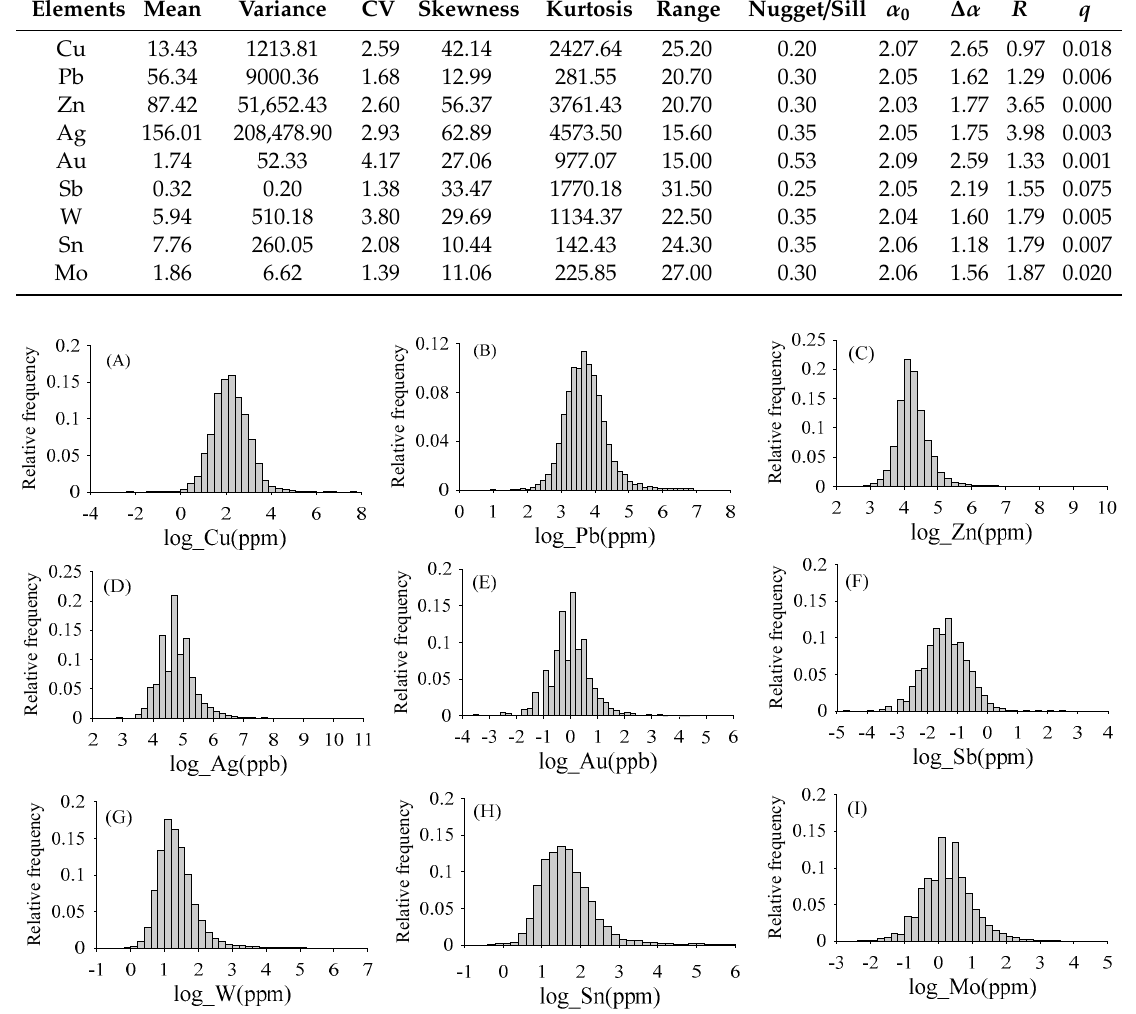
Figure 3. Histograms of 9 selected geochemical elements after logarithmic transformation. ( A ) Cu, ( B ) Pb, ( C ) Zn, ( D ) Ag, ( E ) Au, ( F ) Sb, ( G ) W, ( H ) Sn, ( I ) Mo. Note that the frequency in y -axis have been normalized by the sample size.